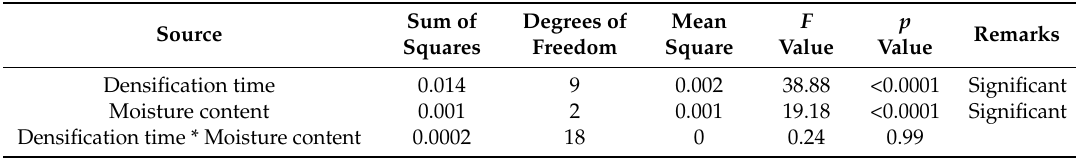
Table 5. Analysis of variance results of thermal conductivity versus densification time and moisture content. Source